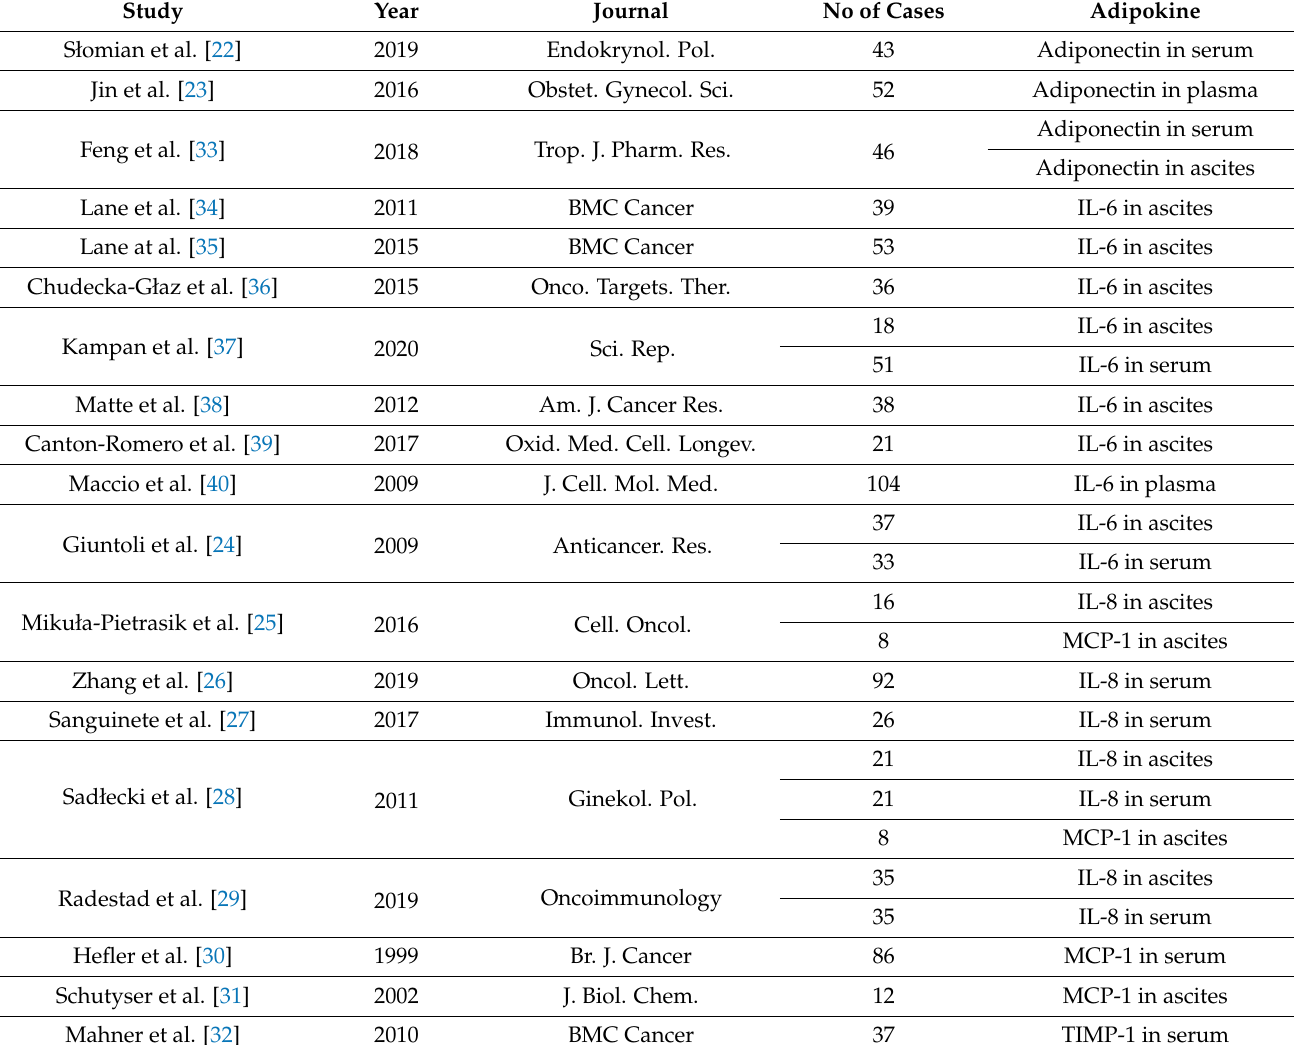
Table 1. Characteristics of quantitative studies